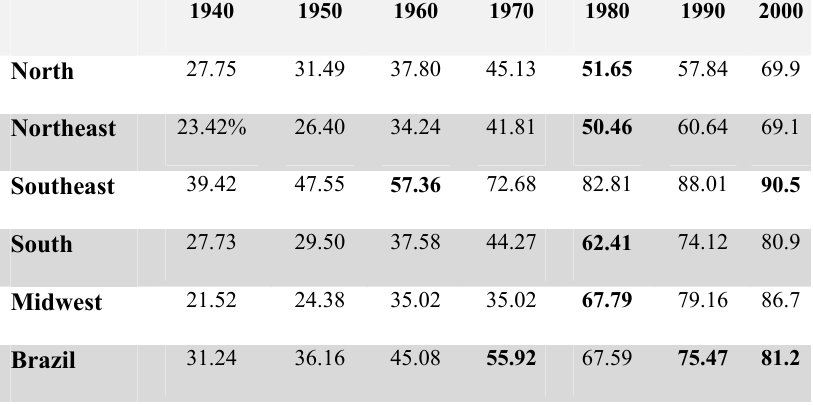
Table XIII. Brazil: Urbanisation percentage rates per region